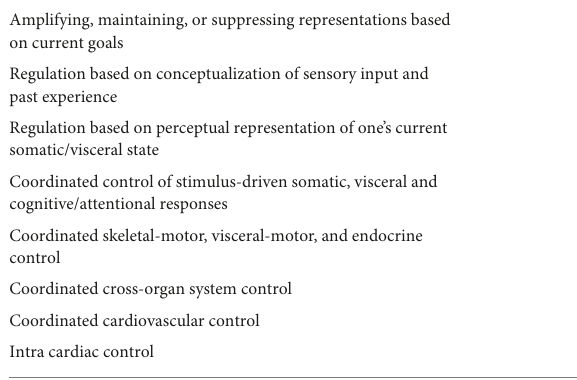
Amplifying, maintaining, or suppressing representations based on current goals Regulation based on conceptualization of sensory input and past experience Regulation based on perceptual representation of one’s current somatic/visceral state Coordinated control of stimulus-driven somatic, visceral and cognitive/attentional responses Coordinated skeletal-motor, visceral-motor, and endocrine